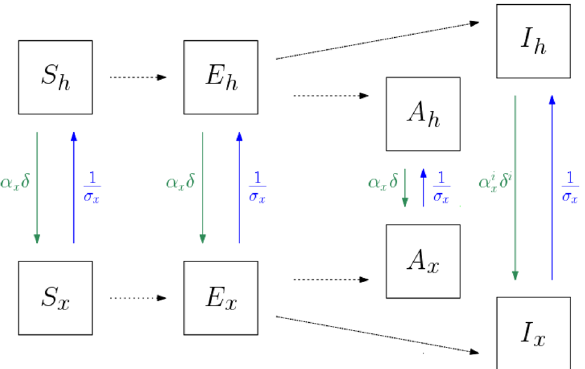
Figure 2. Schematics showing the flow between Susceptible ( S ), Latent ( E ), Infectious ( I ), Asymptomatic ( A ) individuals, between the home location represented by the subscript h , and other locations represented by the subscript x , where x ∈ { w , c , o } , such that w represents work, c educational facilities, and o other locations for example for leisure activities. The black dotted arrows represent transition rates that are due to disease dynamics and are described in Fig. 3. See Table 2 for the description of the parameters of this